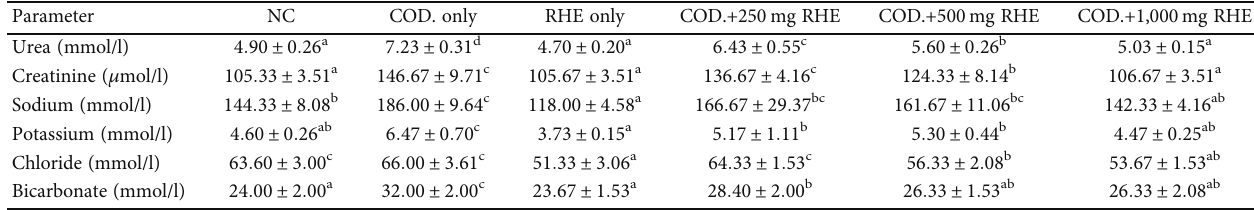
Table 2: E ff ect of rice husk extract on renal markers in codeine-administered male albino Wistar rats. Parameter NC COD. only